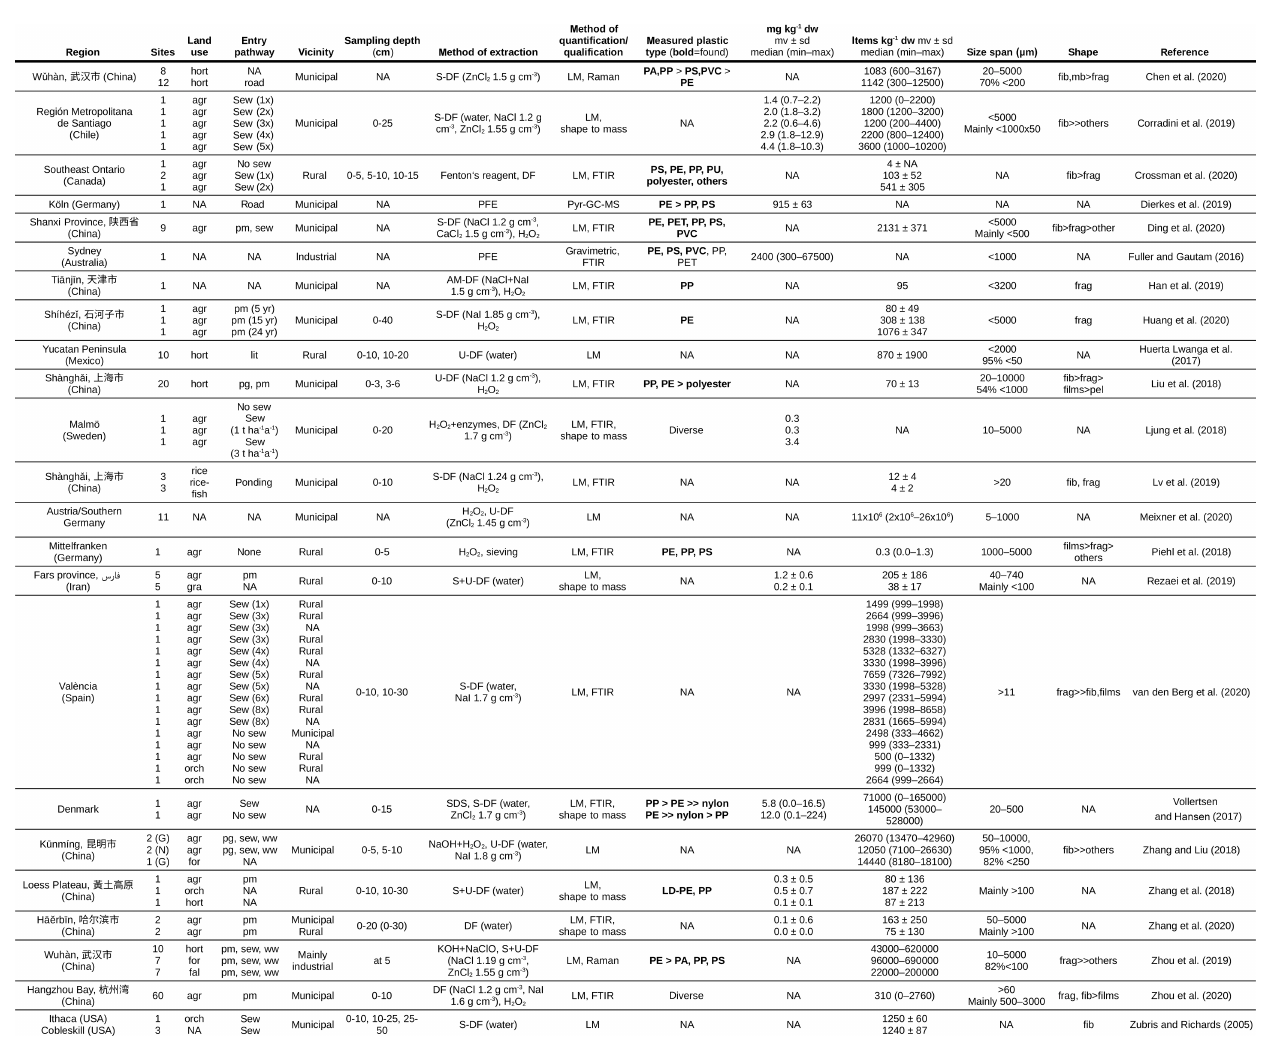
Table 1. Studies on microplastic concentrations with characterization of sites, applied methods and extracted microplastic samples. The abbreviations used in this table are as follows: hort – horticulture; agr – agriculture; gra – grassland; orch – orchard; for – forest; fal – fallow; sew – sewage sludge application; pm – plastic mulching; pg – plastic greenhouses; lit – littering; ww – waste water; S –